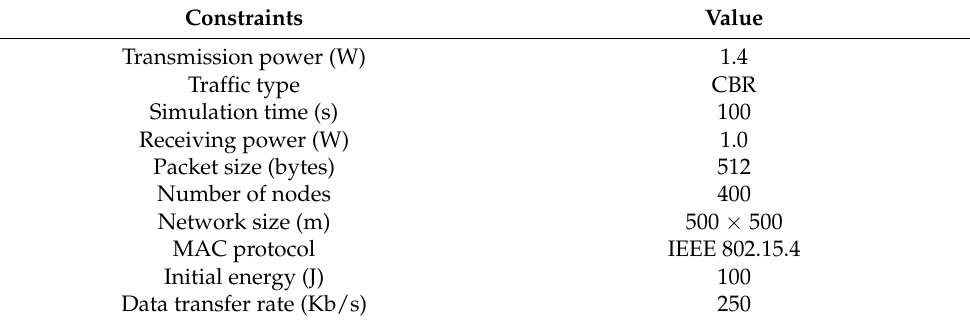
Table 1. Simulation